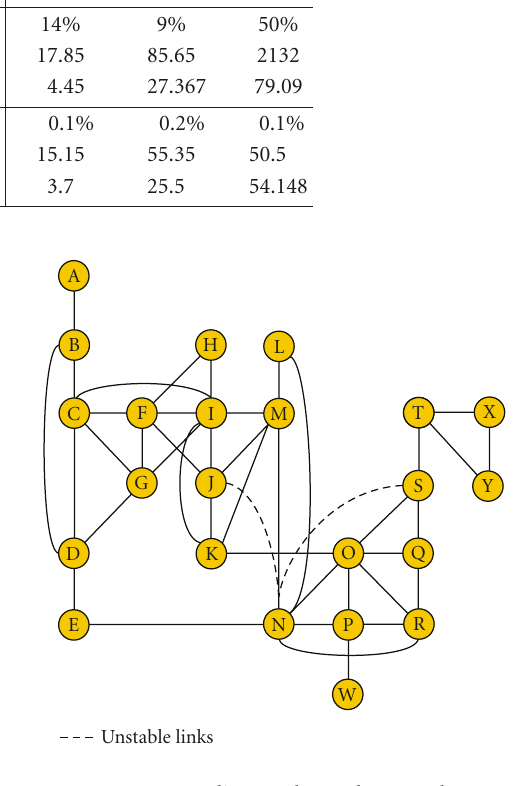
Figure 5: Medium-scale topology